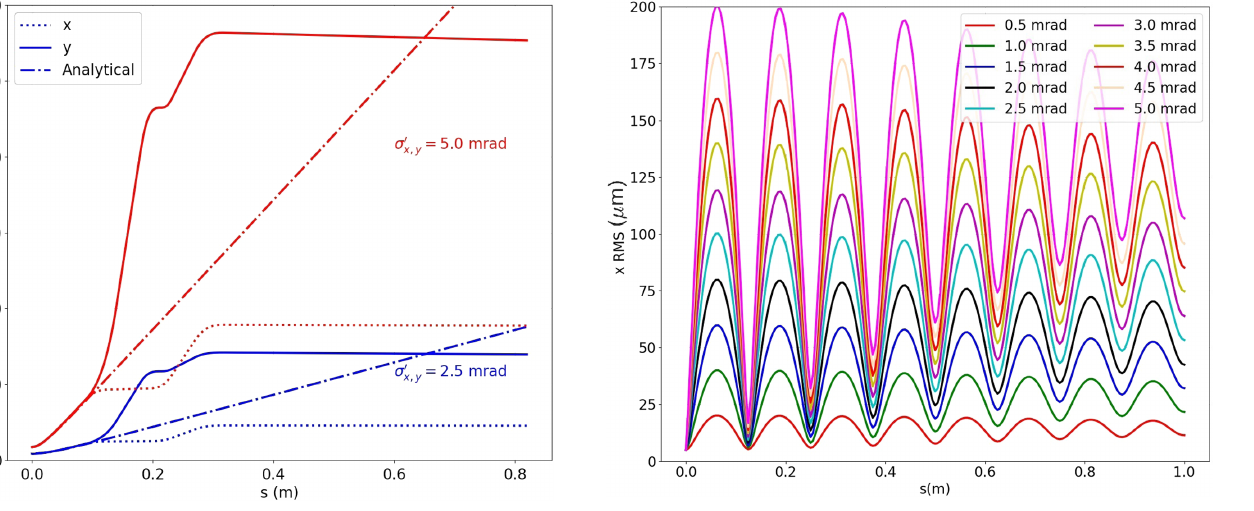
FIG. 9. Normalized emittance evolution along the capture triplet [dotted lines for x , solid lines for y and dash-dotted for Eq. (4)]. The triplet is located at 0.1 m away from the plasma injector exit.